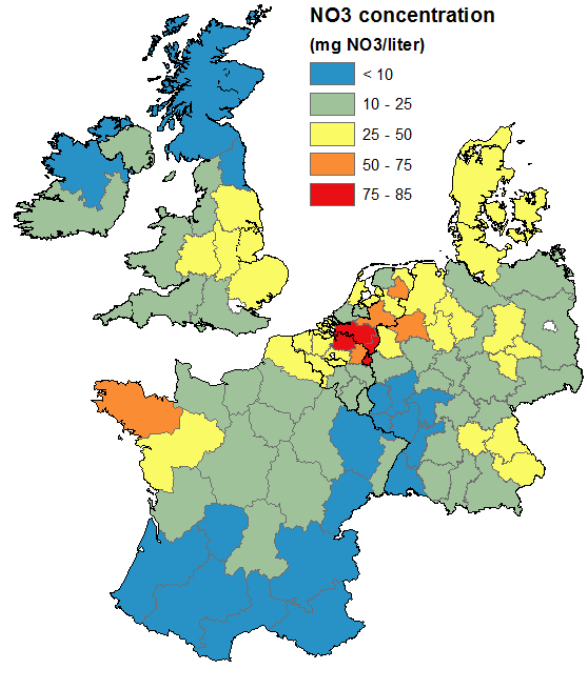
Figure 7. Mean nitrate concentration in leaching water from the root-zone in 2008 at NUTS2 2 level by the MITERRA model. 3 Fig. 7. Mean nitrate concentration in leaching water from the root- 4 zone in 2008 at NUTS2 level by the MITERRA model.